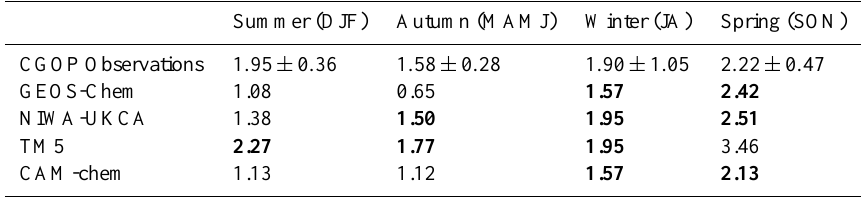
∗ Vertical gradients were calculated using a linear regression of the median 0–8 km observed and simulated profiles, binned in 1 km altitude bins. Simulated gradients are for the Cape Grim background region (see text). Errors on the observed gradients show the 95 % confidence intervals calculated using the bootstrap method with 10000 random samplings from the original data points. Bold values indicate the simulated vertical gradient is within the 95 % confidence interval of the observed slope from